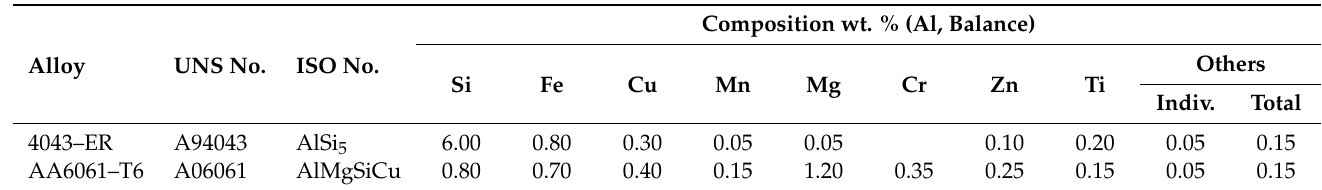
Others Indiv. Total